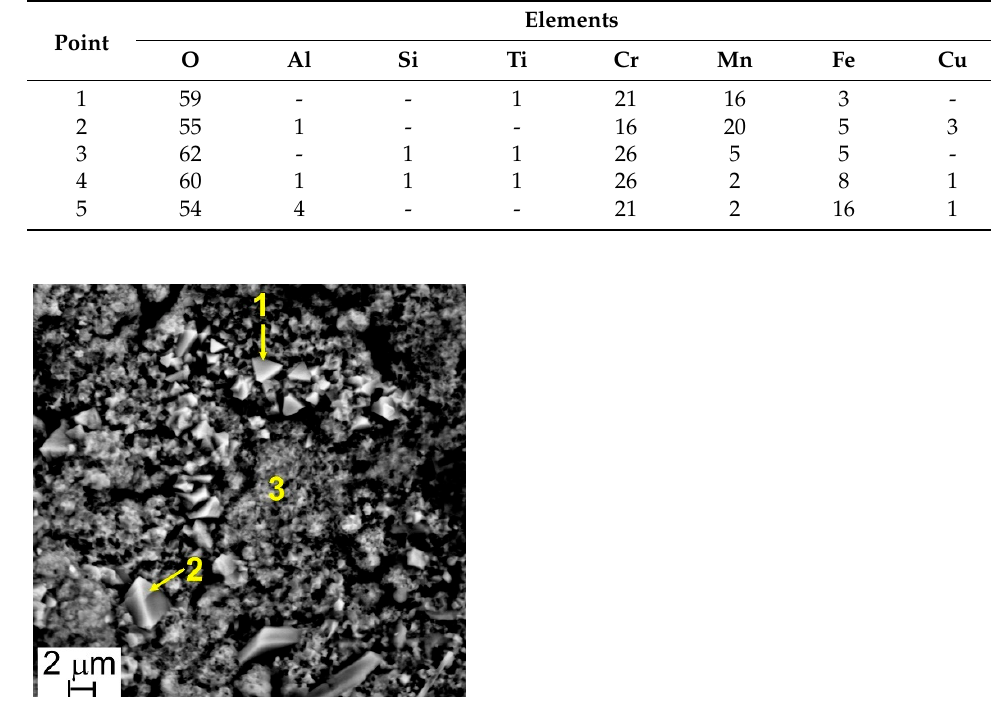
Figure 6. Steel A—SEM-SE micrograph (5000×), and location of Energy Dispersive X-ray Fluores- cence Spectroscopy (EDS) analyses. Table 3. Results of EDS analyses (at.%) performed at points of Figure 6.